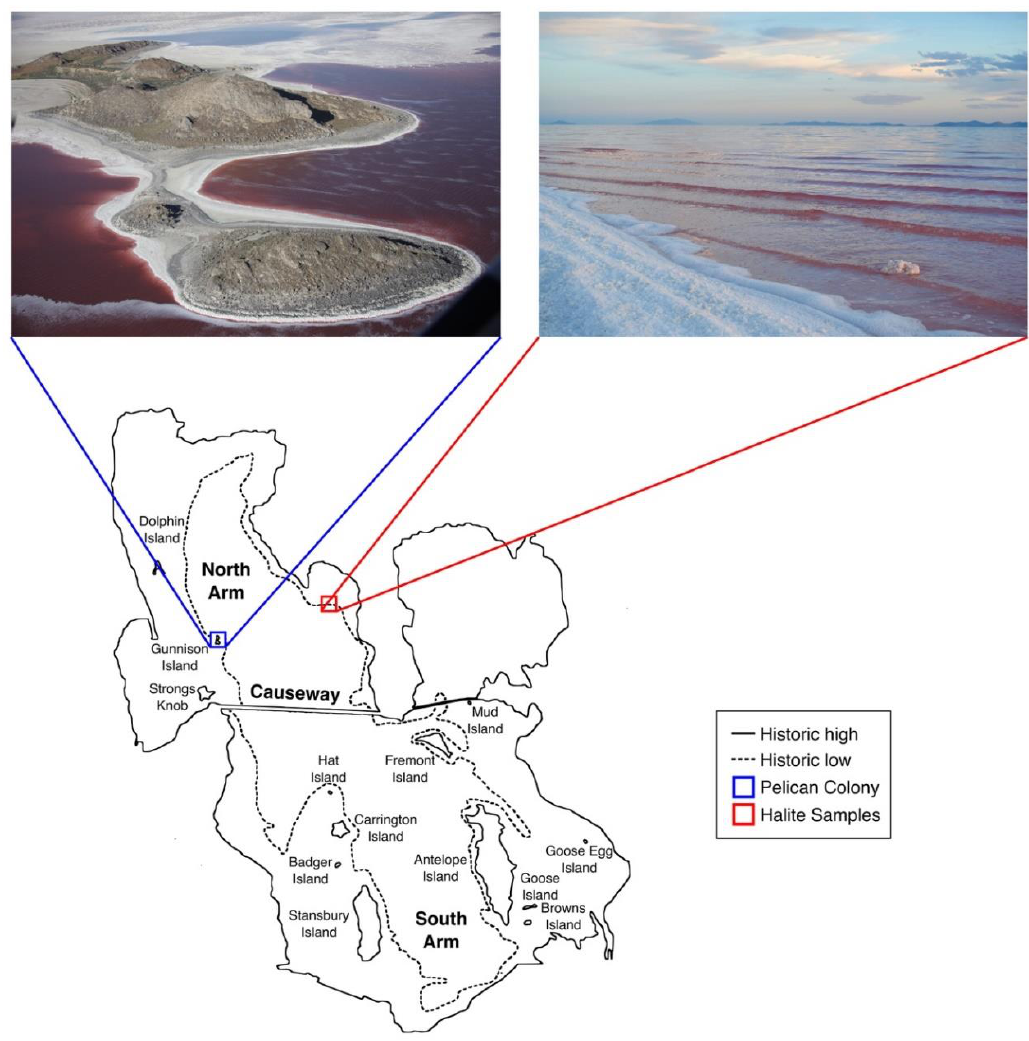
Figure 1. Map of Great Salt Lake depicting the location of the north arm sampling sites: the American White Pelican breeding colony on Gunnison Island (left, blue) and the location of Rozel Bay where halite was collected (right red). The island is a restricted access site as the breeding birds are protected by law. Since the elevation of Great Salt Lake fluctuates over time, we have indicated the high-water line and the historic low elevation. The railroad causeway that separates the hypersaline north arm from the south arm is shown, and the lake’s islands are also indicated. The causeway length is 19 km, which provides scale for this image. Image credit: Great Salt Lake Institute.